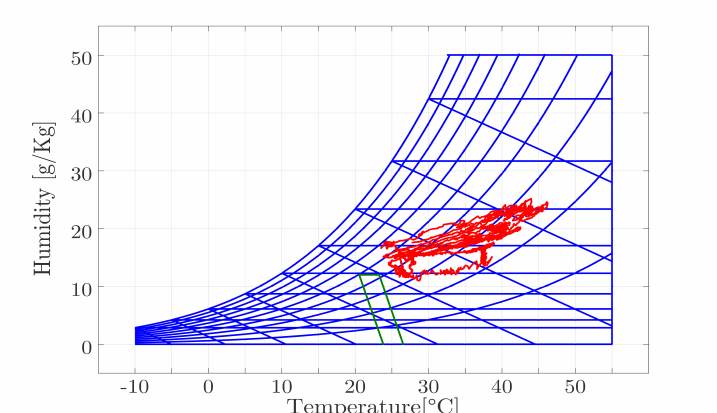
Figure 5. Psychrometric chart of the geodesic dome in Santa